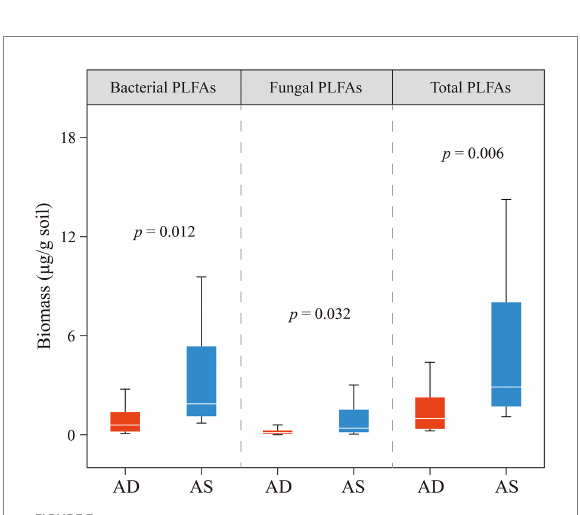
FIGURE 3 Phospholipid fatty acid (PLFA) contents of bacteria, fungi, and total microorganisms in the alpine desert (AD) and alpine steppe (AS). The ends of the boxes in the box plot represent the 25 th and 75 th percentiles. Horizontal lines and whiskers within each box indicate the median and standard deviation, respectively ( n [AD] = 15, n [AS] = 12). p < 0.05 indicates a significant difference in PLFA content between the alpine desert and